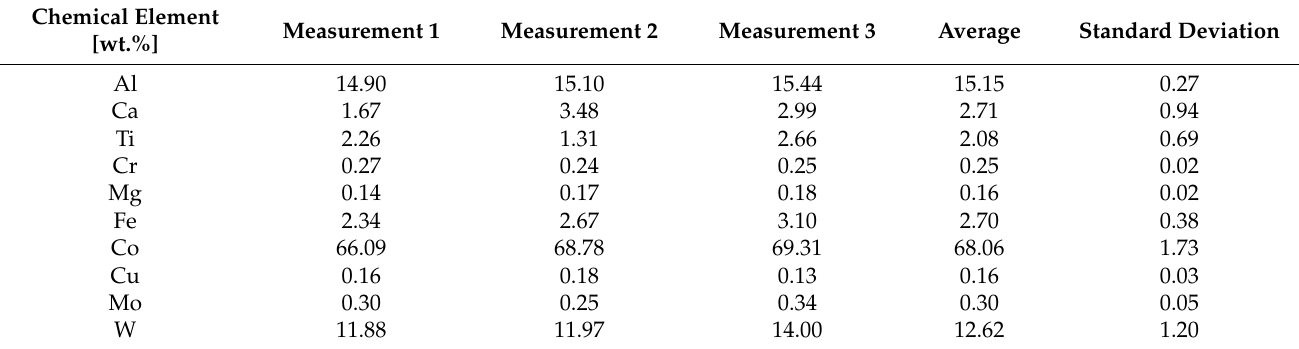
Table 1. Results of the chemical composition of the produced Co70W12Al15 alloy analyzed by an X-ray fluorescence